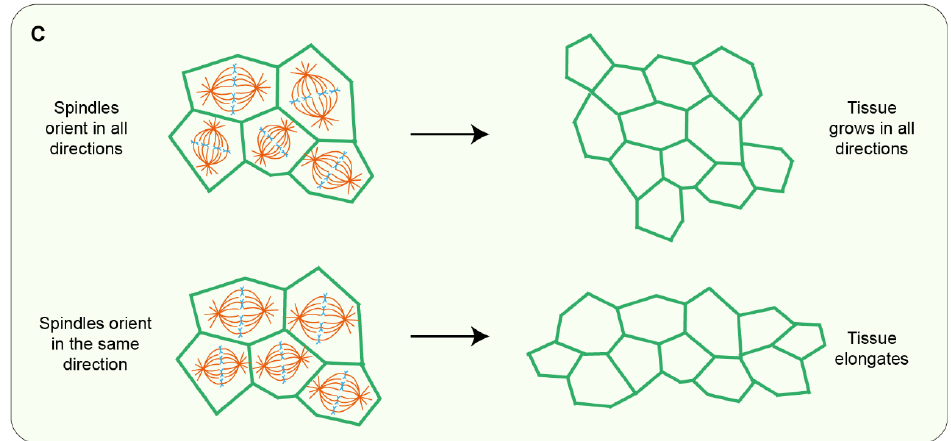
Figure 3. The effect of cell divisions on tissue organisation. ( A ) In symmetric divisions, spindle alignment parallel to the plane of the tissue generates identical, side-by-side daughter cells. ( B ) In asymmetric divisions, the spindle aligns perpendicular to the tissue plane and divisions generate daughter cells with different cell fates, which aid tissue stratification. ( C ) Symmetric divisions that orient uniformly within the tissue plane lead to tissue growth in all directions. However, if the spindles align in the same direction, tissue elongation occurs along the global axis of